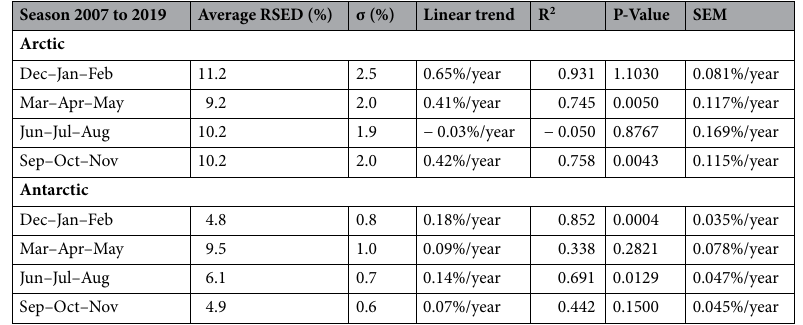
Table 3. Statistics for the seasonal RSED from 2007 to 2019 for each polar region, including average RSED and standard deviation (σ) as well as the linear trend and related R 2 , P-Value and Standard Error of the Mean